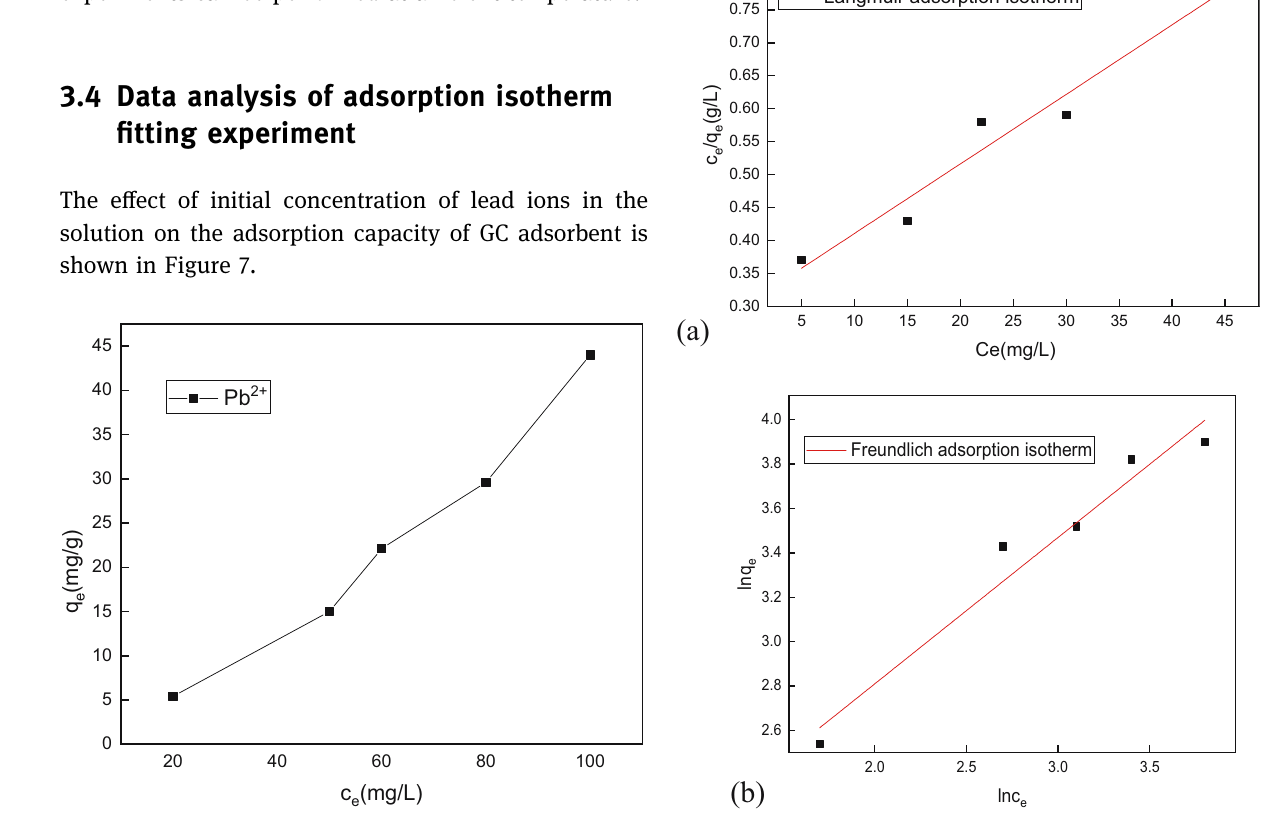
Figure 8: ( a ) Langmuir adsorption isotherm and ( b ) Freundlich adsorption